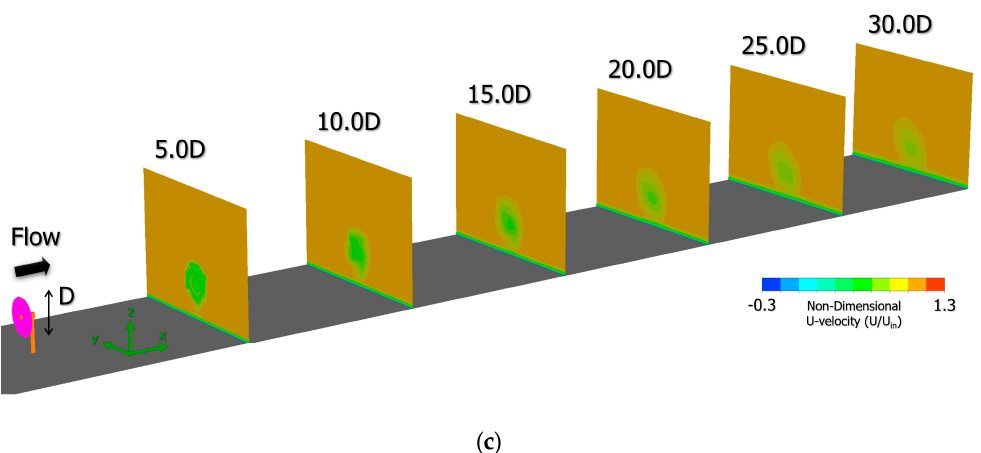
Figure 18. Spatial distribution of U-velocity for time-averaged flow field in y–z plane (front view) at x = 5.0 D, 10.0 D, 15.0 D, 20.0 D, 25.0 D, and 30.0 D: ( a ) N = 4, ( b ) N = 10, and ( c ) uniform flow.